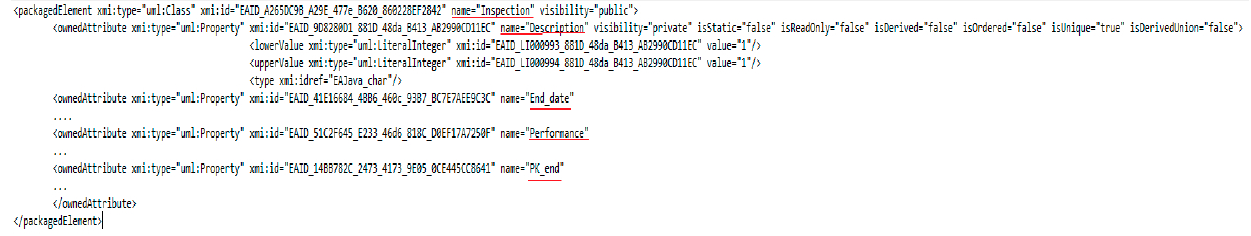
Figure 6. Extract from XML Writing of Class “Inspection”.